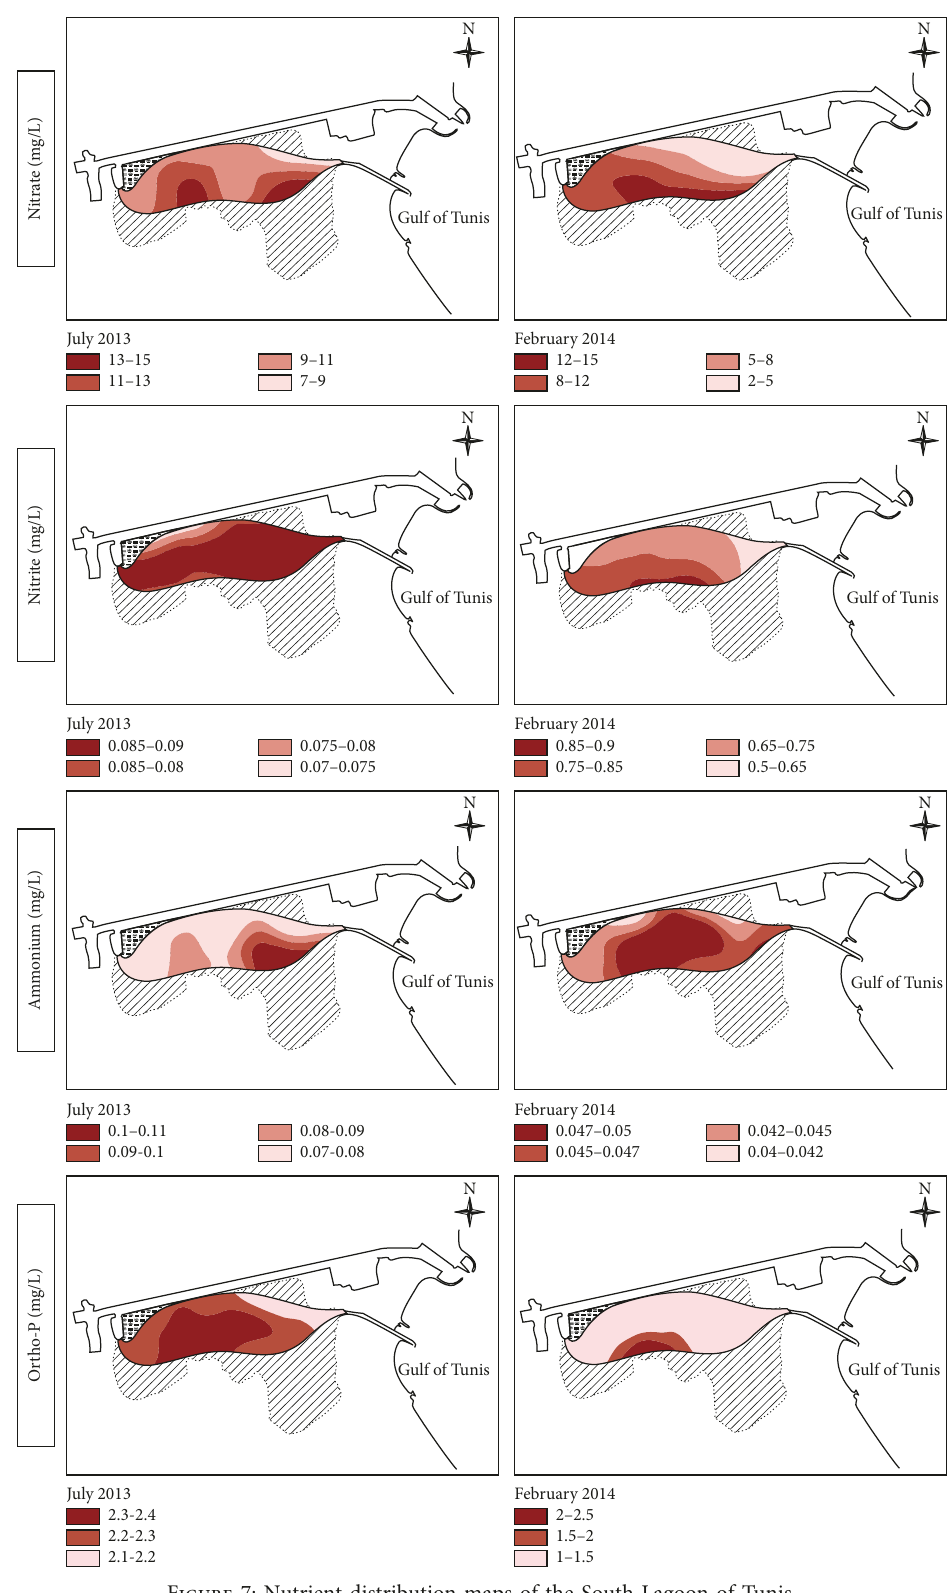
Figure 7: Nutrient distribution maps of the South Lagoon of